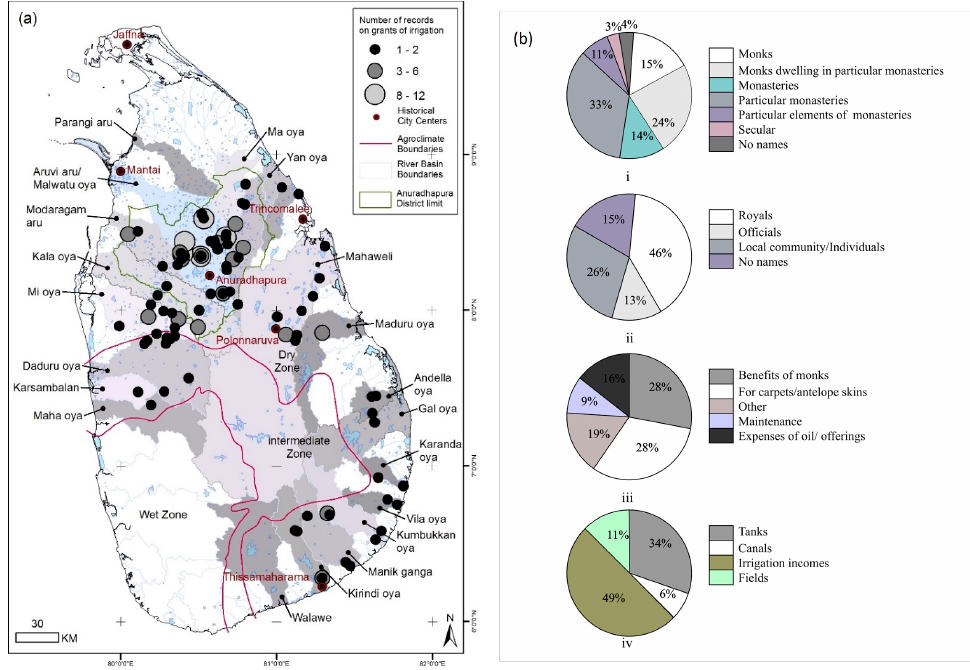
Figure 6. Grants of irrigation: ( a ) Distribution of records on grants of irrigation based on river basins; ( b ) i. percentages of type of grantees, ii. percentages of types of granters, iii. percentages of purpose of grants iv. percentages of elements of irrigation granted.